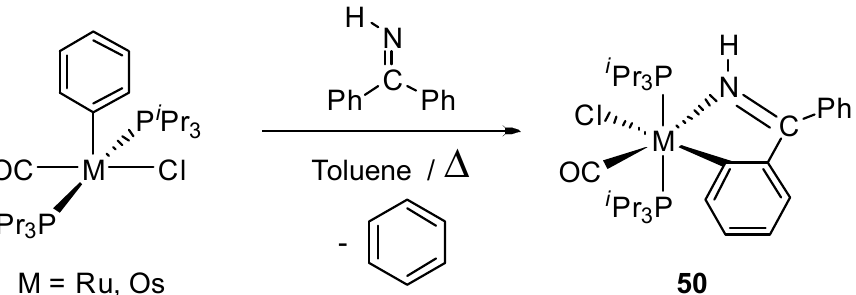
Figure 12. Synthesis of cyclometalated complex by oxidative addition of the phenyl group of an imine and subsequent reductive elimination.